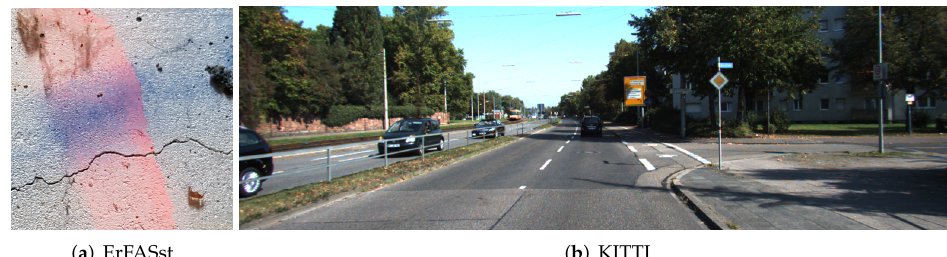
Figure 4. Infrastructure mapping datasets.